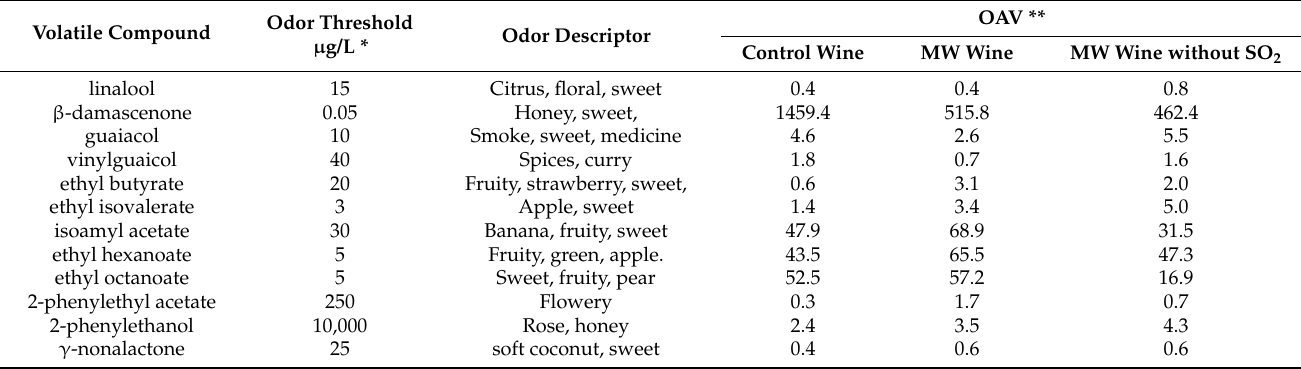
Table 4. Odor-active values of the most sensorially significant volatile compounds in control wines and microwave-treated wines fermented with and without SO 2